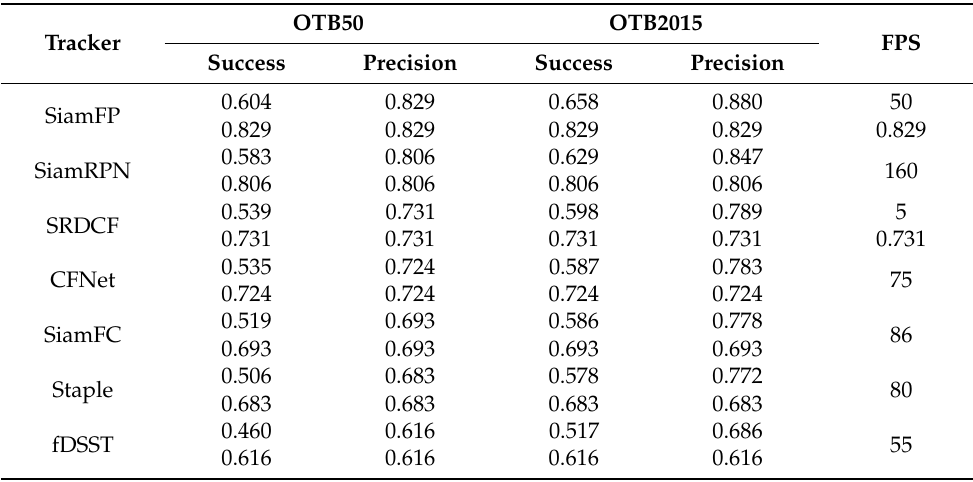
Table 2. Tracking Results on OTB